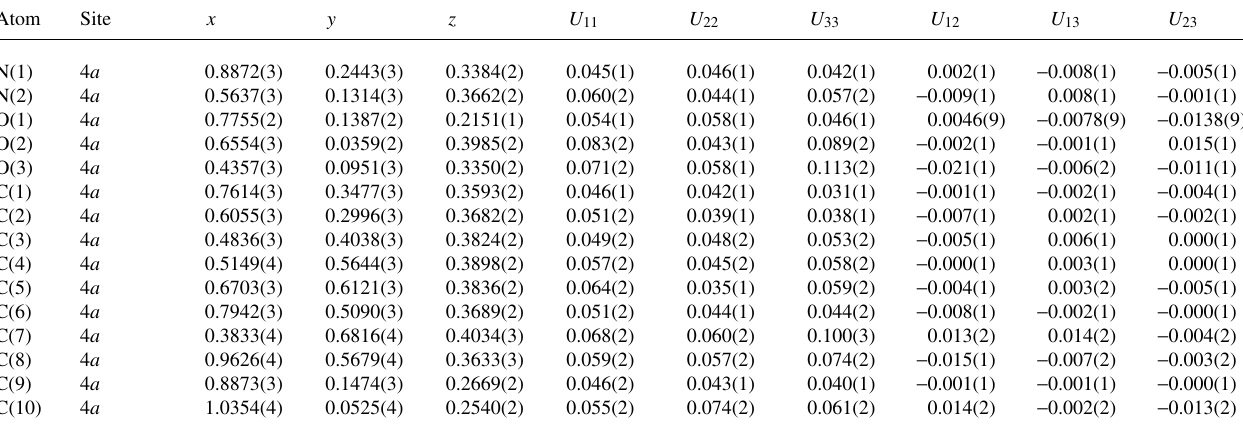
Table 3. Atomic coordinates and displacement parameters (in Å 2 )